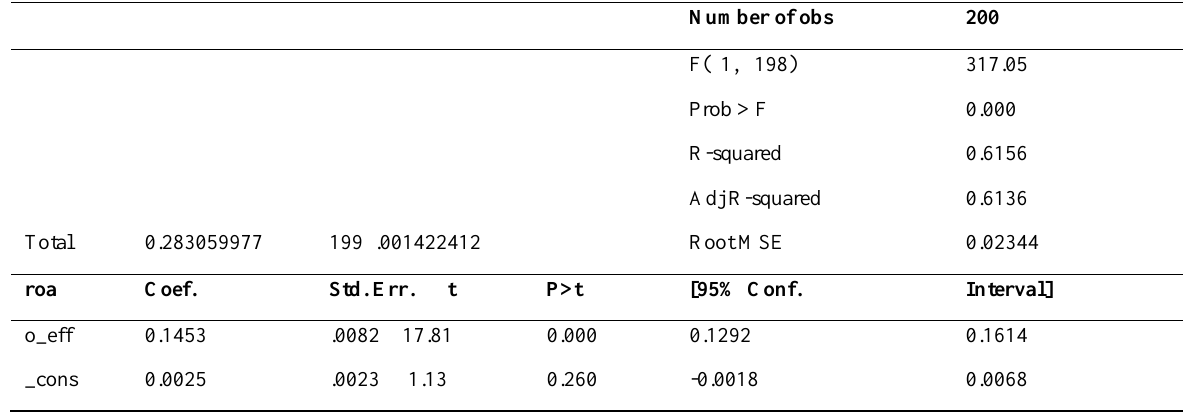
Table 2: Effect of the Operating Efficiency Risk Exposure on Financial Performance